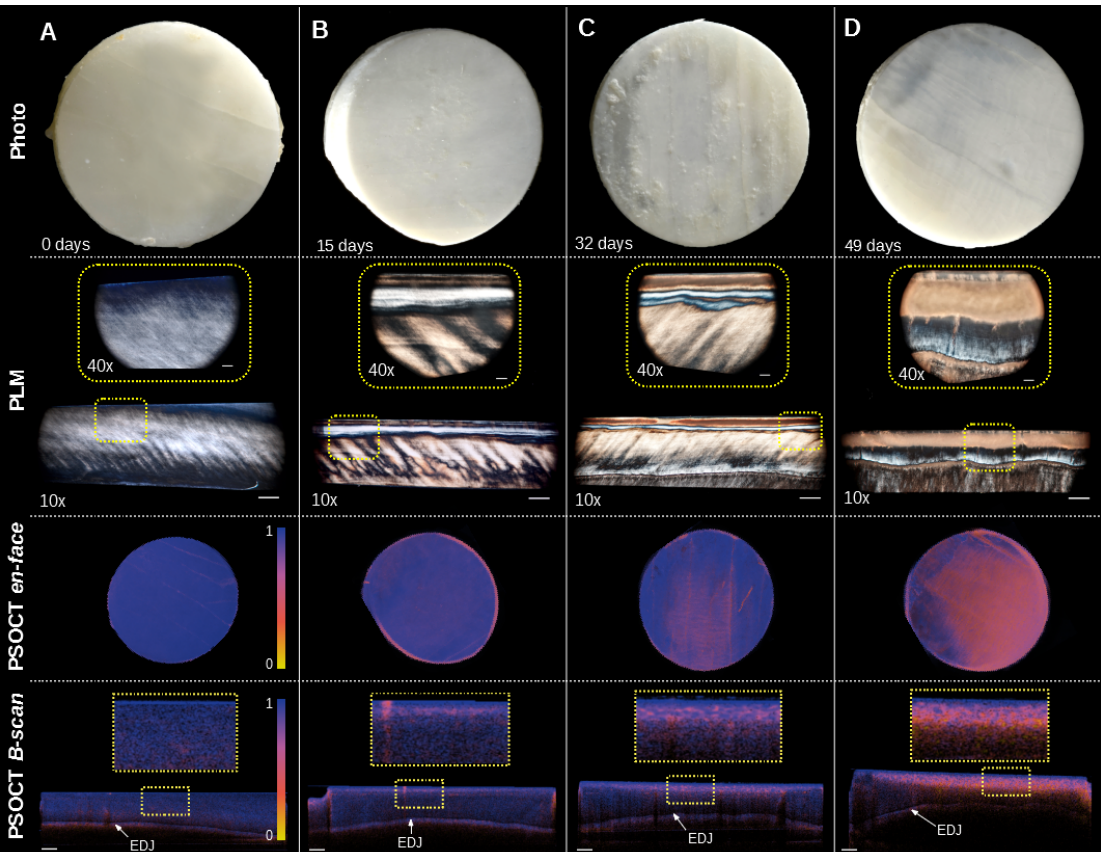
Figure 2. Overview of the results: Photographs of the demineralized enamel slabs, PLM images of the thin cross sections with two different magnifications, degree of polarization (DOP) representations of the PSOCT measurements as en-face projections and B-scans, including samples with a demineralization time of 0 ( A ), 15 ( B ), 32 ( C ), and 49 ( D ) days. EDJ: Enamel dentin junction. Scale bars PLM: 400 µm (10 × ), 80 µm (40 × ); Scale bar PSOCT: 400